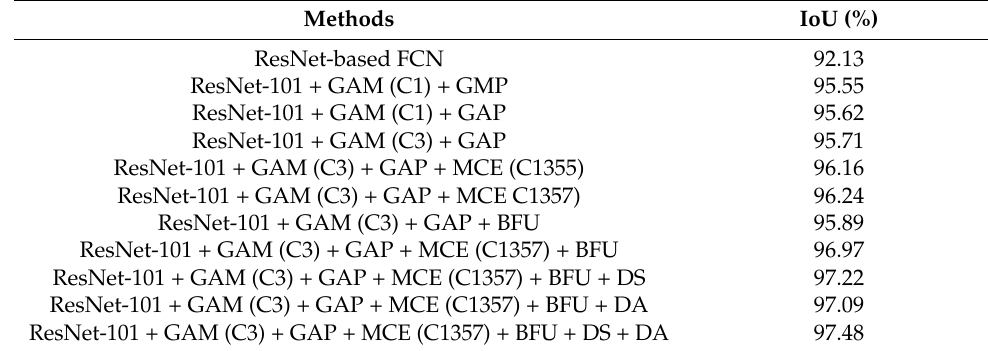
Table 8. Effects of GAM, MCE and BFU on the extraction results of mangroves.